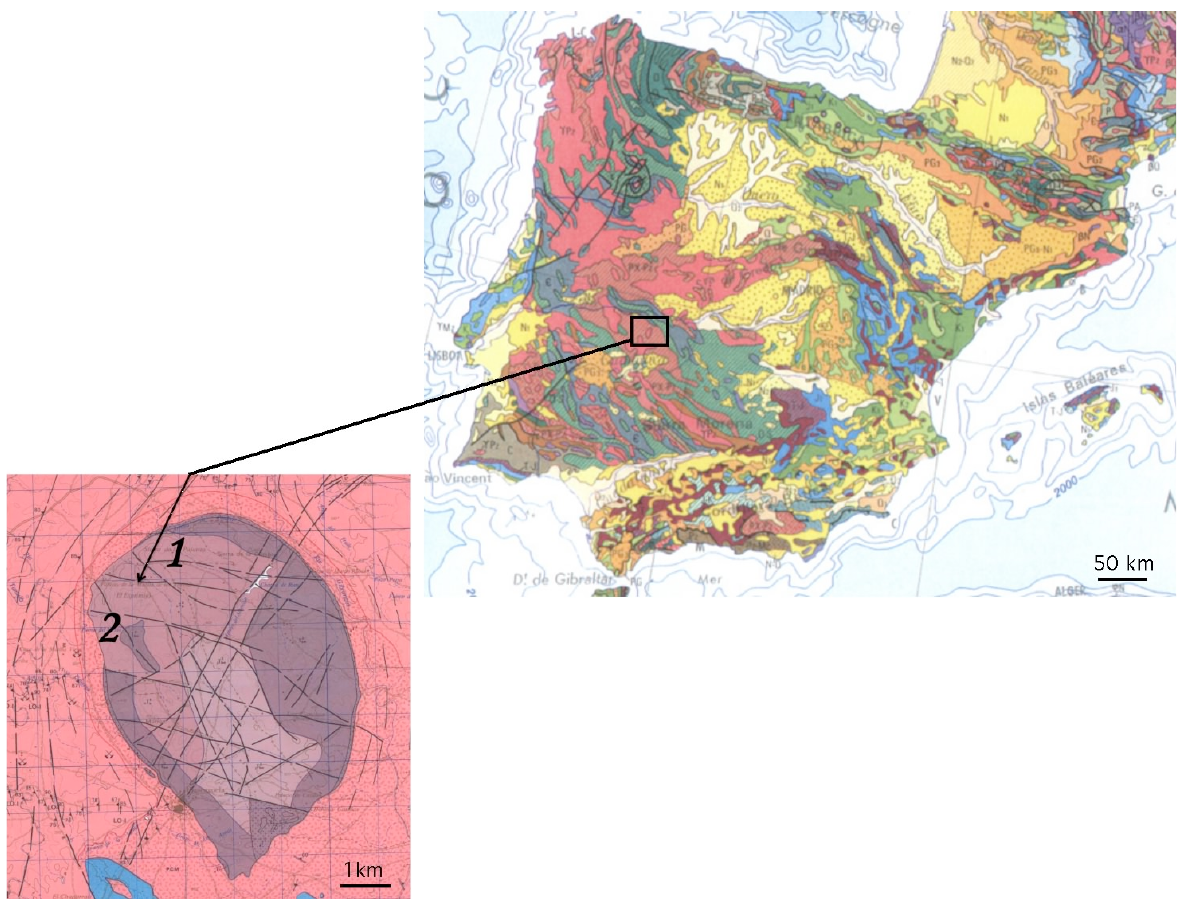
Figure 1. Location of the Plasenzuela pluton. 1: Azul Platino and Amarillo Platino quarry; 2: Azul Trujillo and Amarillo Trujillo quarry. The map of Plasenzuela pluton is from Montesern and P´erez Rojas (1982). The geological map of Spain is from http://www.iberianature.com/material/spaingeology.html (last access: 1 November 2011